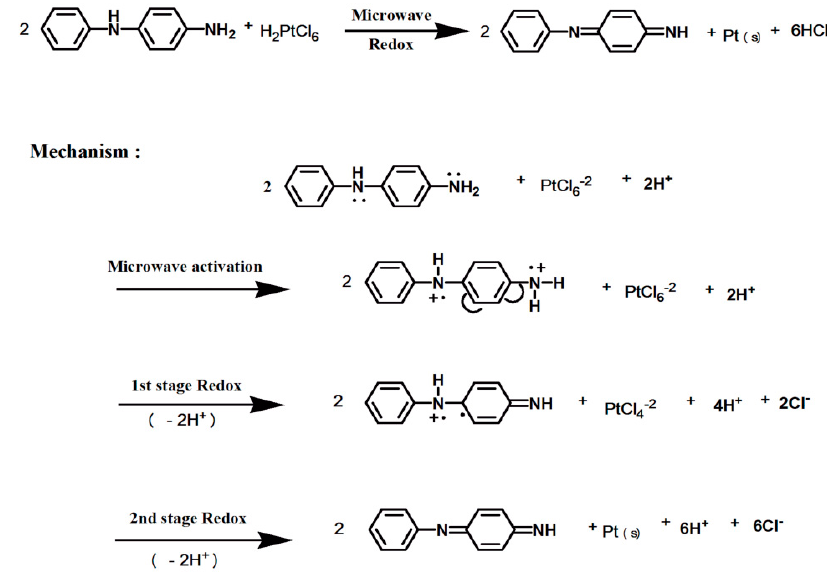
Scheme 2. Mechanism of the microwave assisted redox reaction between PPDA and